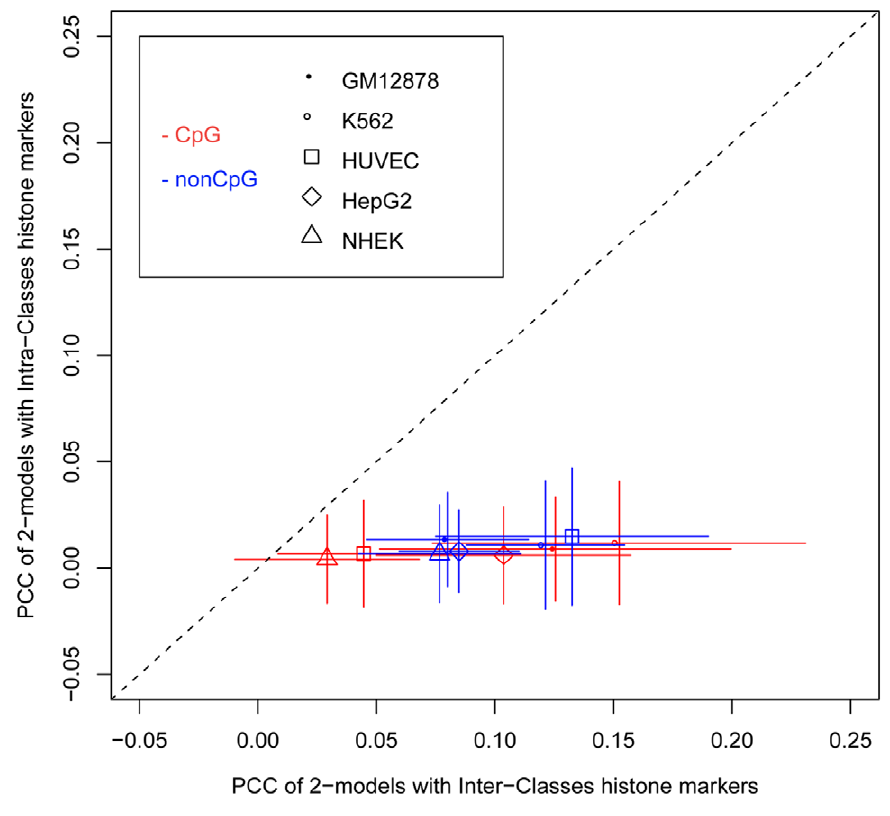
Figure 4. Predictive power of 2-models. The dots represent the predictive power of the models, blue and red indicating models were trained and tested in CpG-related and nonCpG-related promoters, respectively. The x-axis is the PCC generated by the 2-models involved in two histone modifications, one is from Class I, and the other is from Class II. The y-axis is the PCC generated by the 2-models involving two histone modifications from the same class, either Class I or Class II. Error bars give the standard derivations within the two cases.